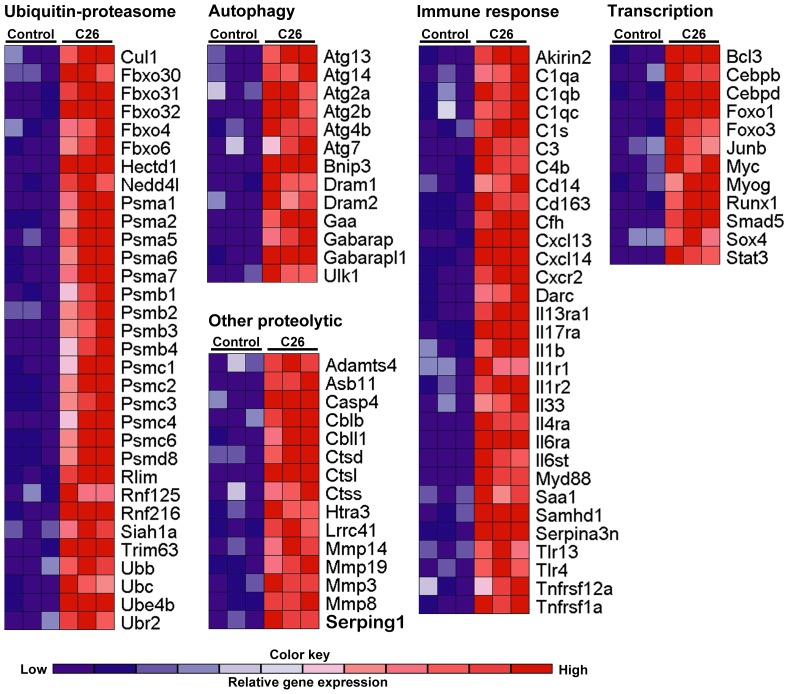
Heatmaps of selected upregulated genes in plantar flexor muscles from several functional categories.Data are from muscles at 25 days post-tumor inoculation (severe cachexia). Red color in the heatmap represents gene upregulation in muscles from C26 mice compared to the lower control values represented by blue. All genes represented are increased greater than 1.5-fold. Genes involved in: ubiquitin-proteasomal protein degradation, autophagy, other proteolytic processes (e.g. caspases, cathepsins, and metalloproteases), immune responses (innate and adaptive), and transcription factor genes are shown. The heatmaps capture most of the upregulated genes in these functional categories but do not represent a complete list (see Table S2). Each color block represents one pooled sample (control n = 3; C26 n = 3).